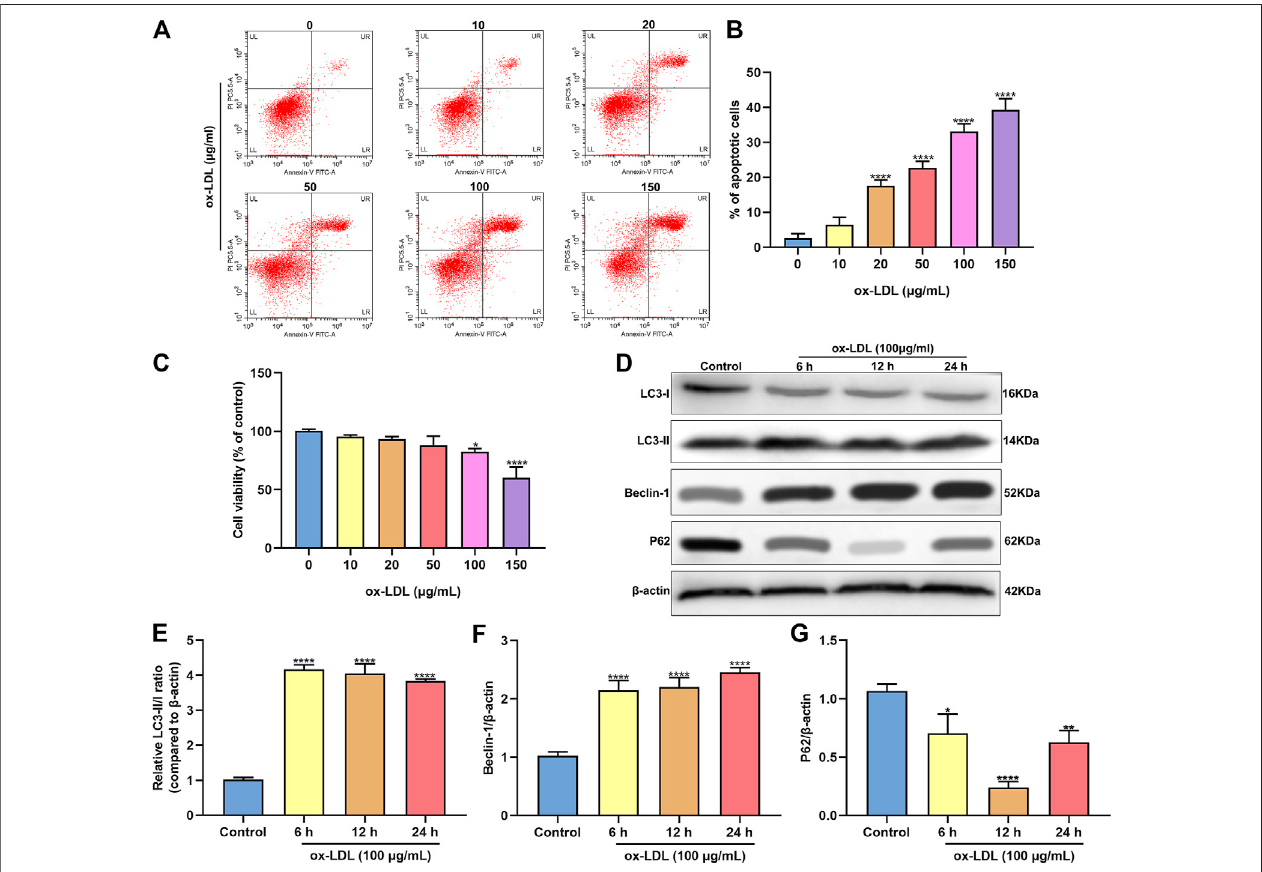
FIGURE 1 | ox-LDL exposure heightens apoptosis and autophagy in HUVECs. (A,B) Flow cytometry assay results showing the apoptotic levels of HUVECs stimulatedby0,10,20,50,100and150 ° μ g/mlox-LDLfor24 ° h. (C) CCK-8assaywasutilizedforassessmentoftheviabilityofHUVECsstimulatedby0,10,20,50,100 and150 ° μ g/mlox-LDLfor24 ° h. (D) RepresentativeimagesofwesternblotsforLC3-I,LC3-II,Beclin-1andP62inHUVECsstimulatedby100 ° μ g/mlox-LDLfor6,12and 24 ° h. LC3- II / I ratio (E) , Beclin-1 (F) and P62 expression (G) levels were separately quanti fi ed. * p < 0.05; ** p < 0.01 and **** p <